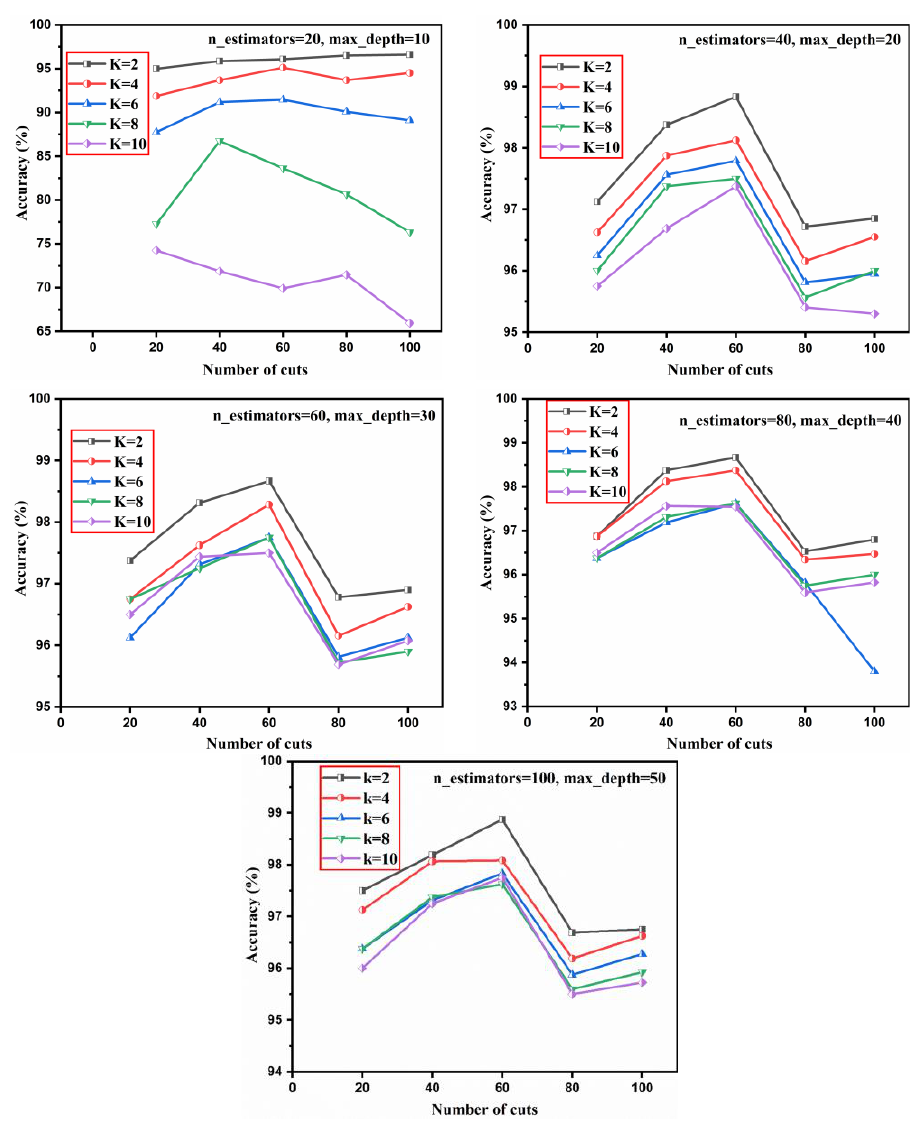
Figure 6. Accuracy percentage achieved with K-mer-based RF model with different parameters.